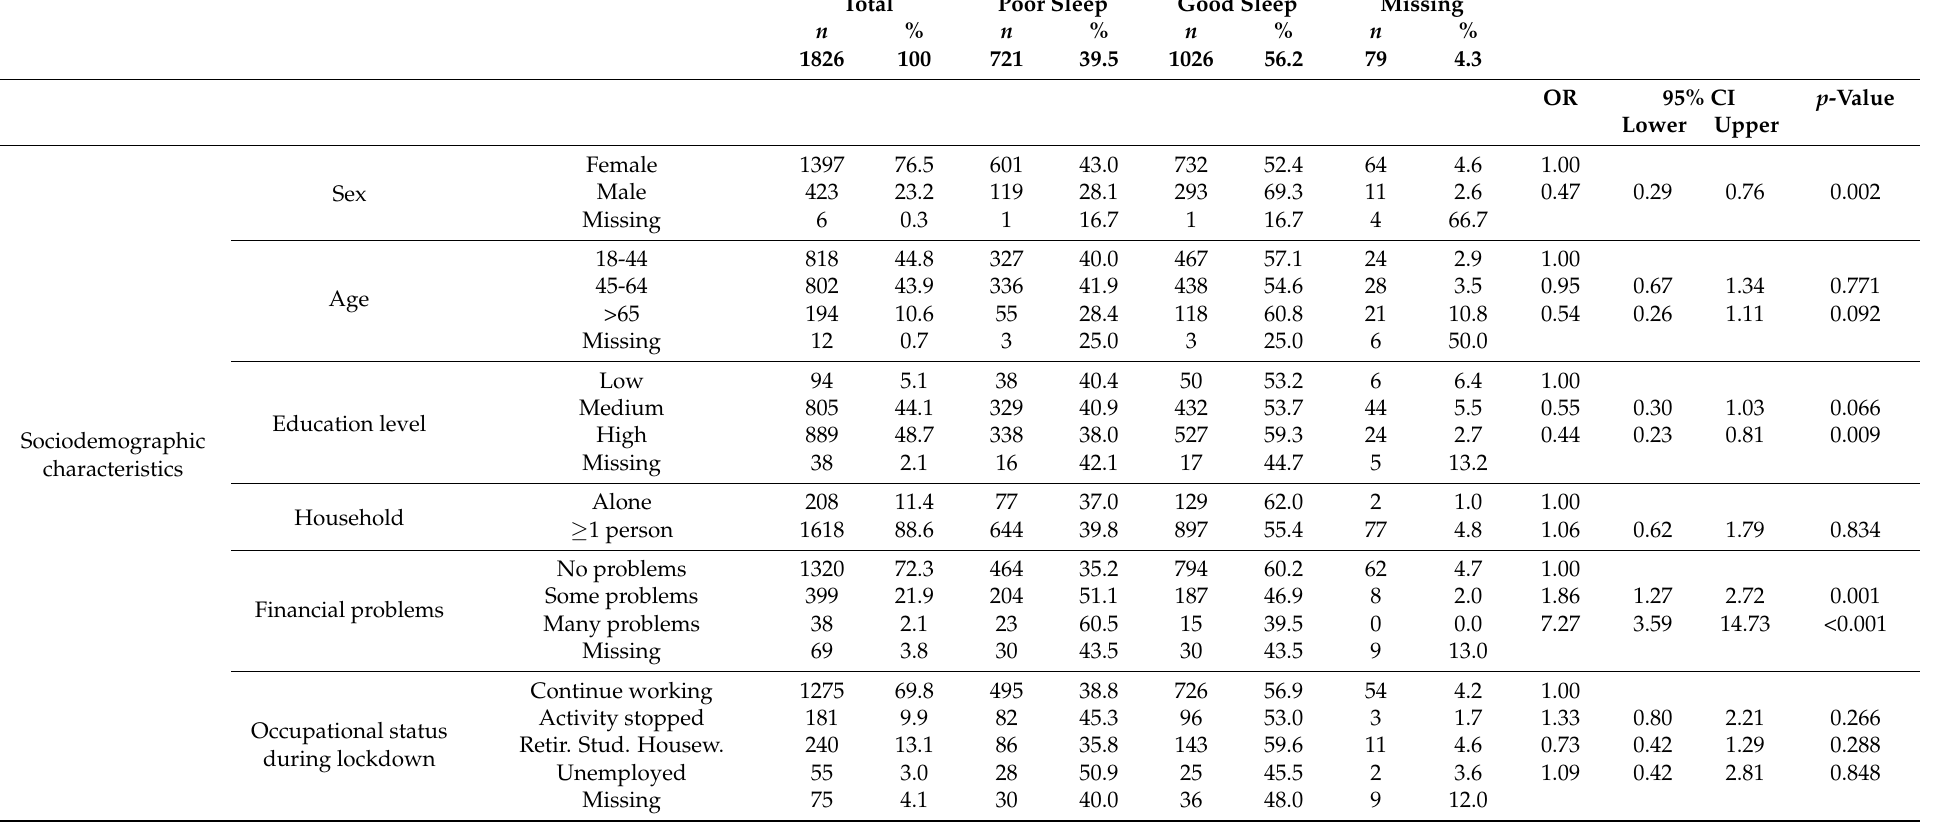
Table 1. Odds ratio for quality of sleep during lockdown by sociodemographic characteristics, work-related factors, changes in lifestyle and psychological